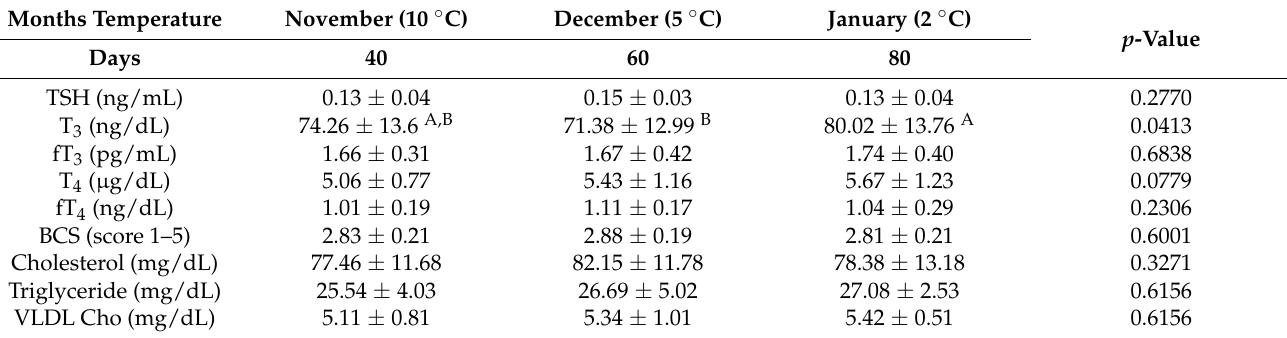
Table 4. Circulating thyroid-stimulating hormone (TSH), total and free triiodothyronine (T 3 , fT 3 ), total and free thyroxine (T 4 , fT 4 ) concentrations, body condition score (BCS), and lipidic panel (mean ± sd) in lactating periods of 30 Nicastrese goats. Within each row, different superscript letters indicate significantly different values. Temperature measurements refer to the environmental temperature at the sampling